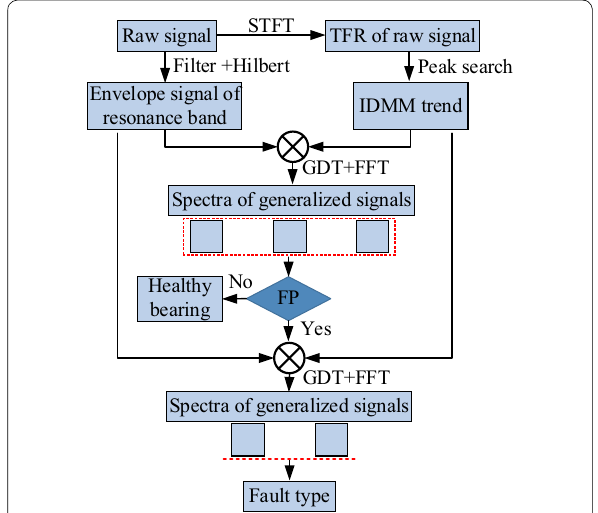
Figure 5 Flowchart of proposed bearing fault diagnosis